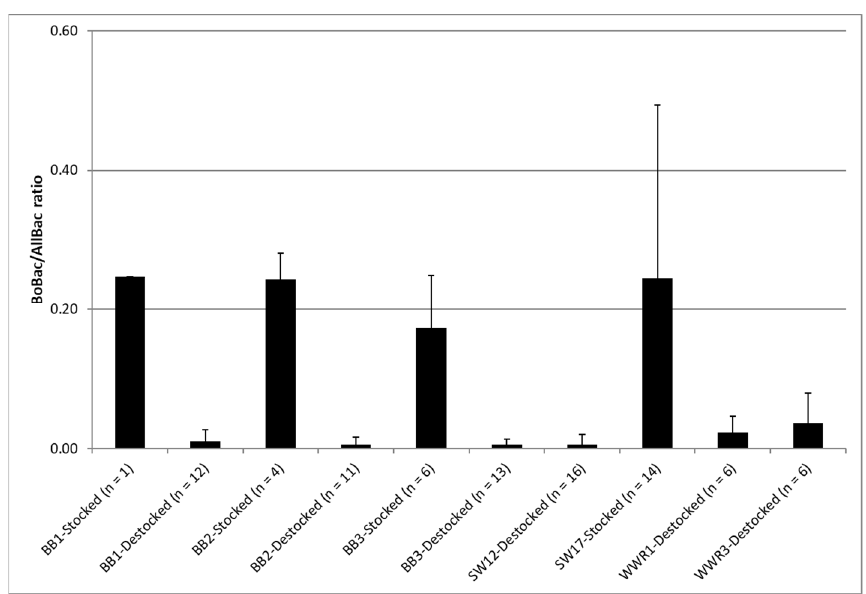
Figure 5. Comparison of BoBac/AllBac ratio when sites were stocked and destocked. The error bars on each bar indicate one standard deviation.